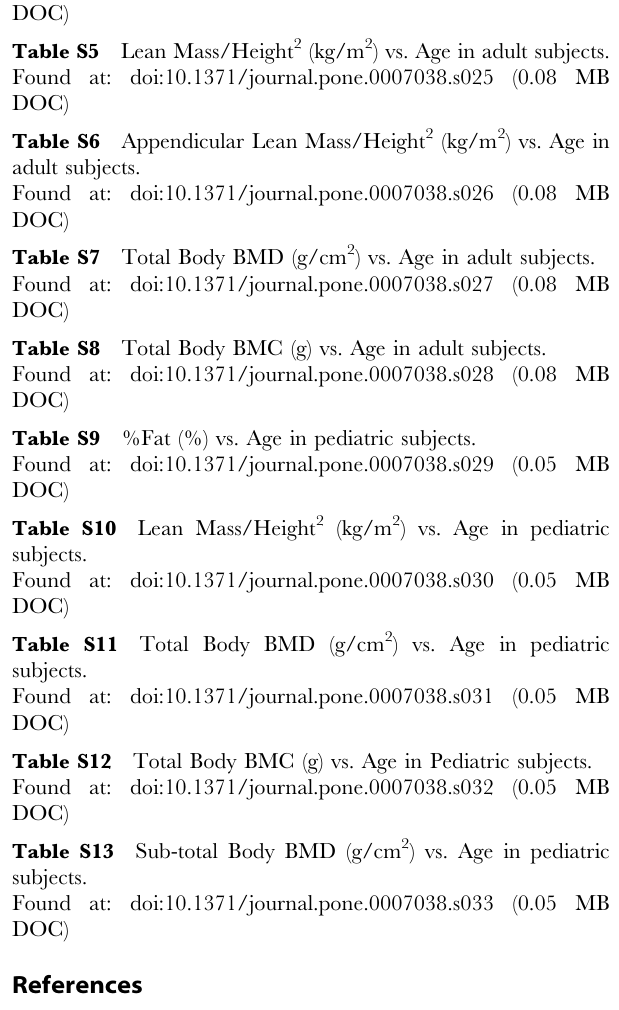
Table S13 Sub-total Body BMD (g/cm 2 ) vs. Age in pediatric subjects.